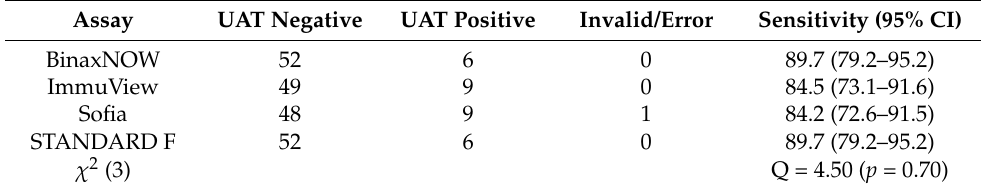
Table 4. Specificity of four Streptococcus pneumoniae urine antigen tests in patients without